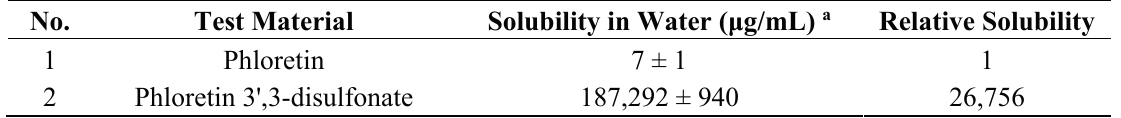
Table 1. Solubility of phloretin and phloretin sodium